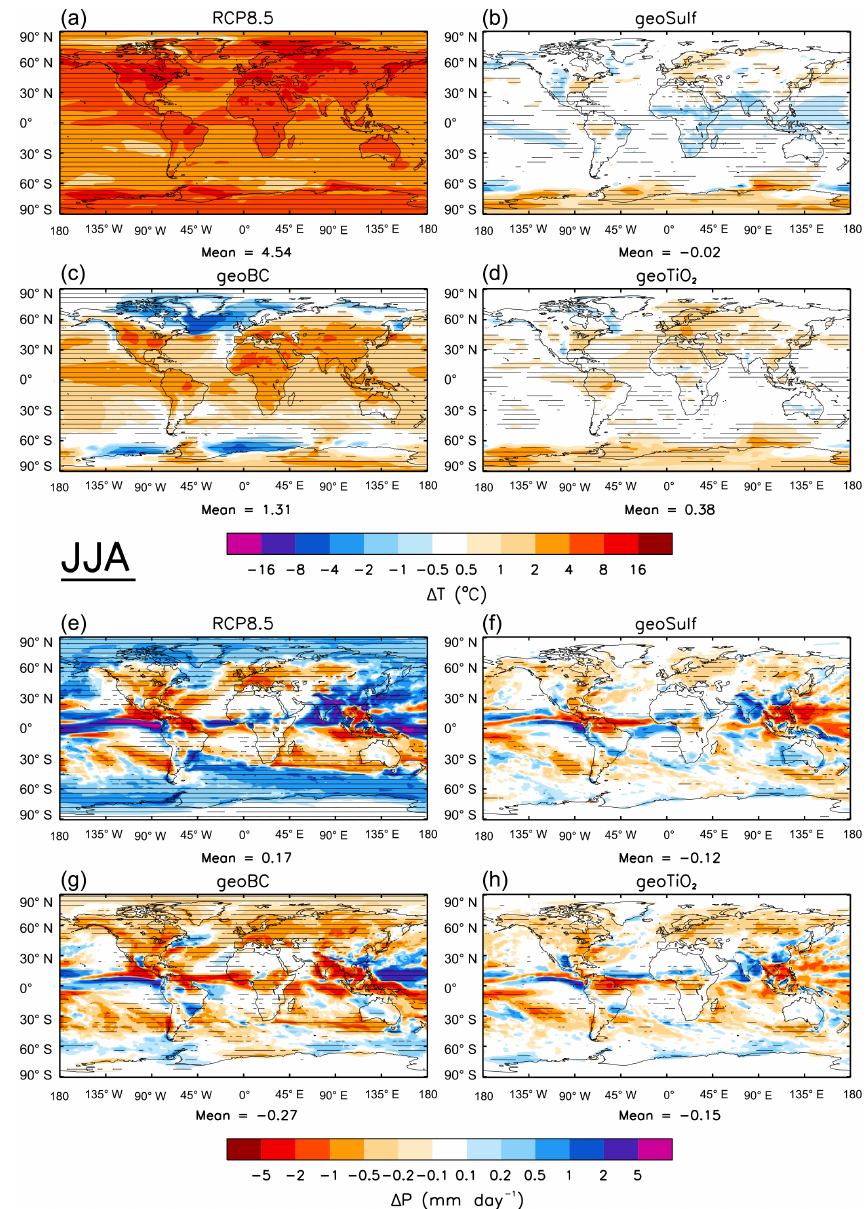
Figure 7. JJA near-surface air temperature (top) and precipitation rate (bottom) anomalies with respect to